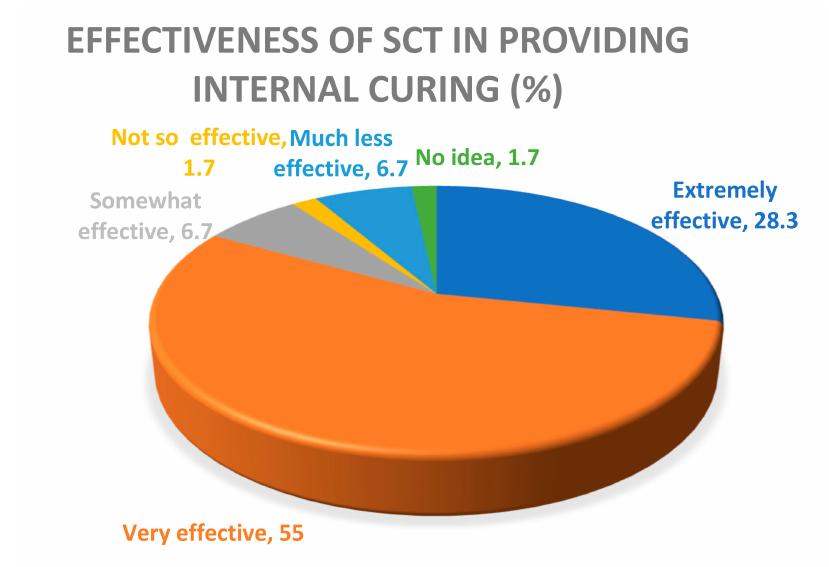
Figure 4. Perceived effectiveness of SC in providing internal water.